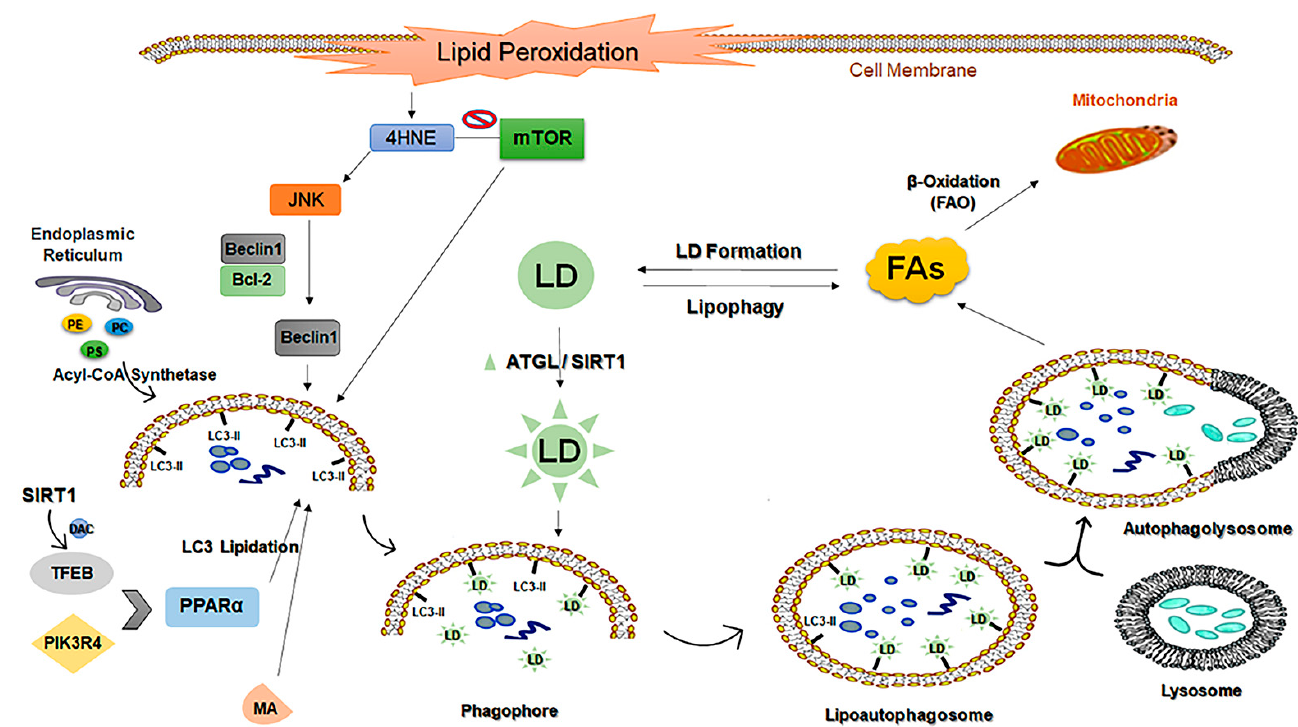
Figure 5. Crosstalk between lipids and autophagy. Lipids can modulate autophagy through different mechanisms.